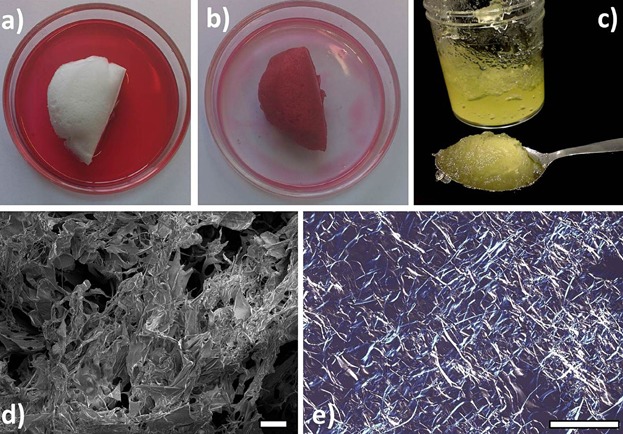
(a and b) Porous cryogel absorbing over 100 times its weight of liquid sunflower oil doped with Sudan red; (c) oleogel containing 98 wt% liquid sunflower oil prepared by shearing oil-sorbed cryogel; (d) cryo-SEM image of dried cryogel showing open porous structure (scale bar = 100 μm); and (e) PLM image of oleogel showing a network of birefringent polymer strands (scale bar = 200 μm).